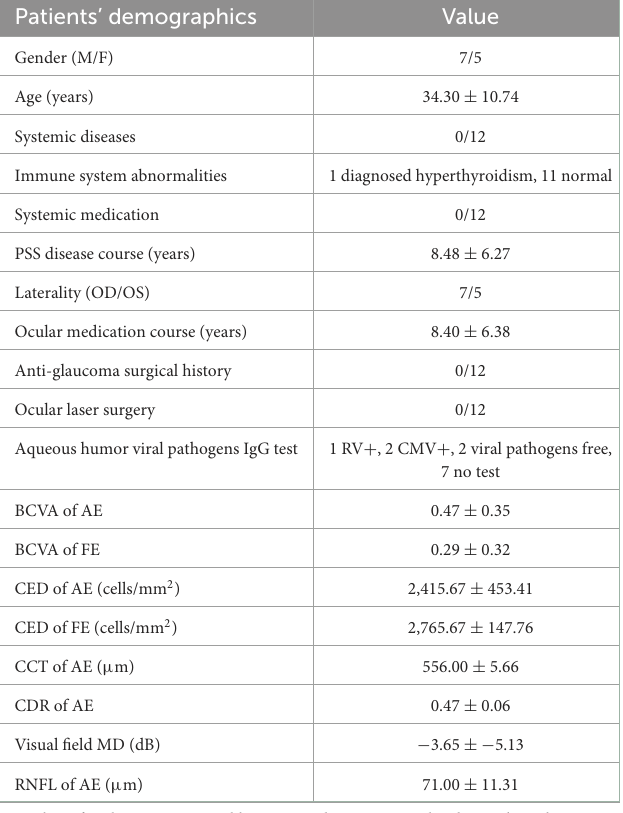
TABLE 1 The demographics and previous medication of PSS patients undergoing relapses following COVID-19